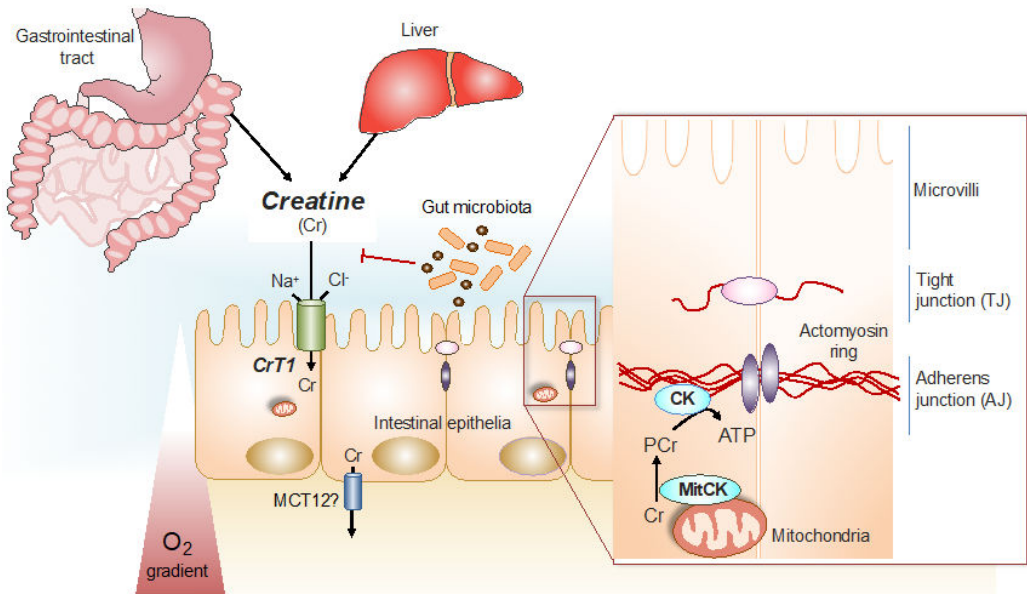
Figure 1. Cr/CK shuttle and the intestinal mucosal barrier. Cr is derived from dietary sources in the gastrointestinal tract, or by de novo synthesis primarily in the kidney and in the liver [12]. The Na + and Cl − dependent creatine transporter (CrT1), expressed in the apical membrane of intestinal epithelial cells, facilitates Cr uptake from the gut lumen [11,14]. Potential routes for Cr absorption into systemic circulation include paracellular movement by solvent drag transport, or via basolateral Cr transport by the monocarboxylate transporter 12 (MCT12) [15]. Gut microbiota express specific enzymes that can mediate Cr and creatinine (Crn) breakdown. In hypoxic intestinal epithelial cells, cytosolic CK localizes to apical adherens junctions in complex with the actomyosin cytoskeletal network, providing a conduit for rapid ATP generation during the energy-dependent processes of epithelial junction assembly and barrier restitution [16]. Adapted from